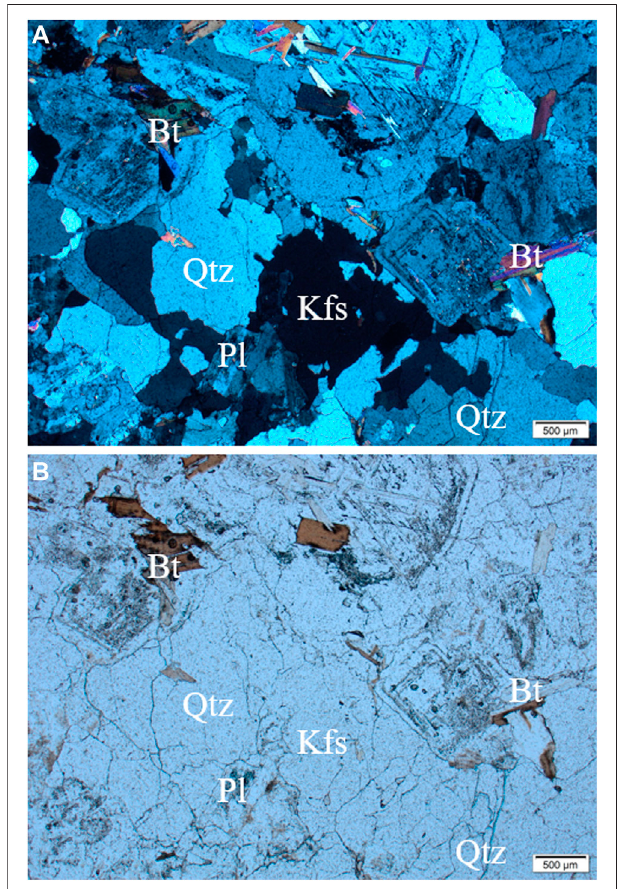
FIGURE2| Opticalmicrographoftestedgranite. (A) Crossedpolars (B) , plane polarized light [quartz (Qtz), K-feldspar (Kfs), plagioclase (Pl), and biotite